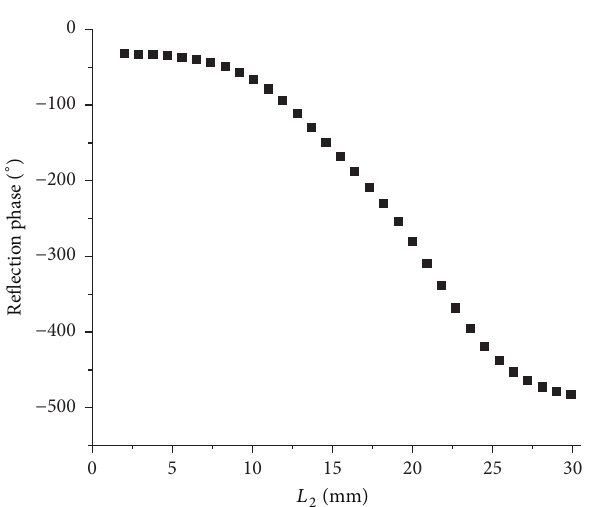
Figure 2: The reflection phase versus the square ring outer length 𝐿 2 .